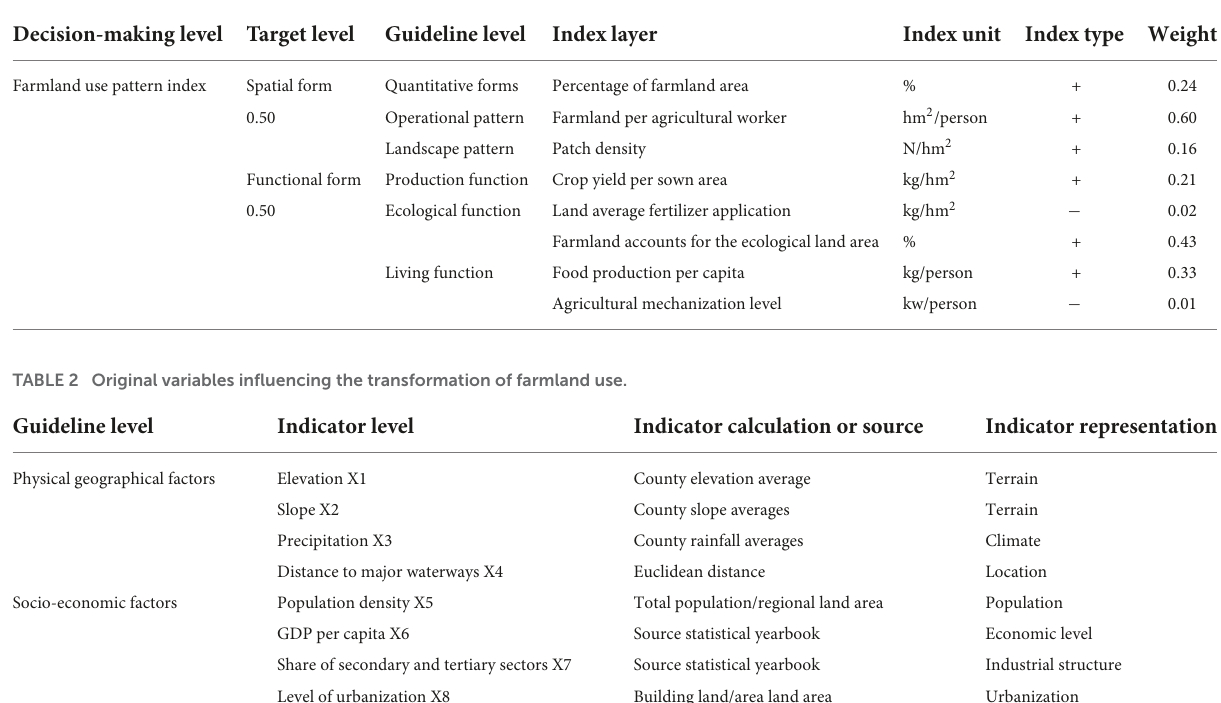
TABLE 1 Farmland use pattern indicator system.